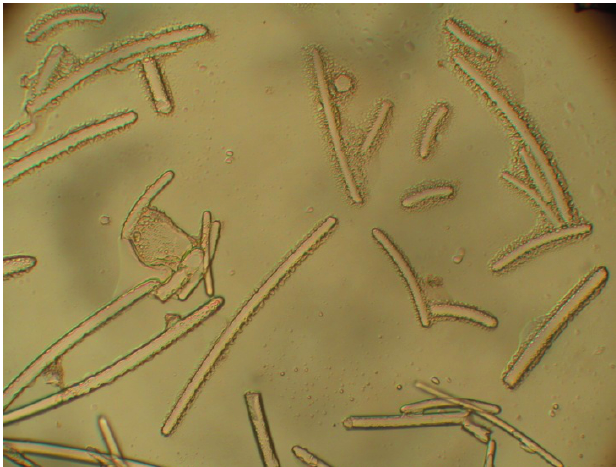
Figure 5. Spicules of the ectosomal periphery observed using an optical